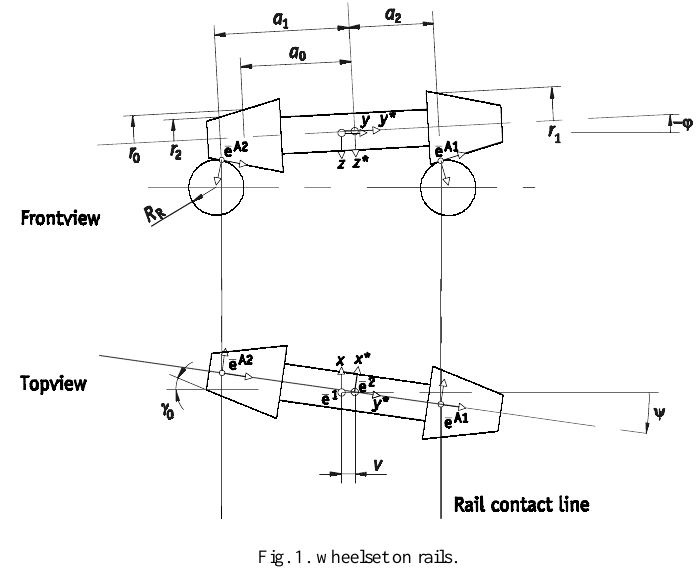
Fig. 1. wheelset on